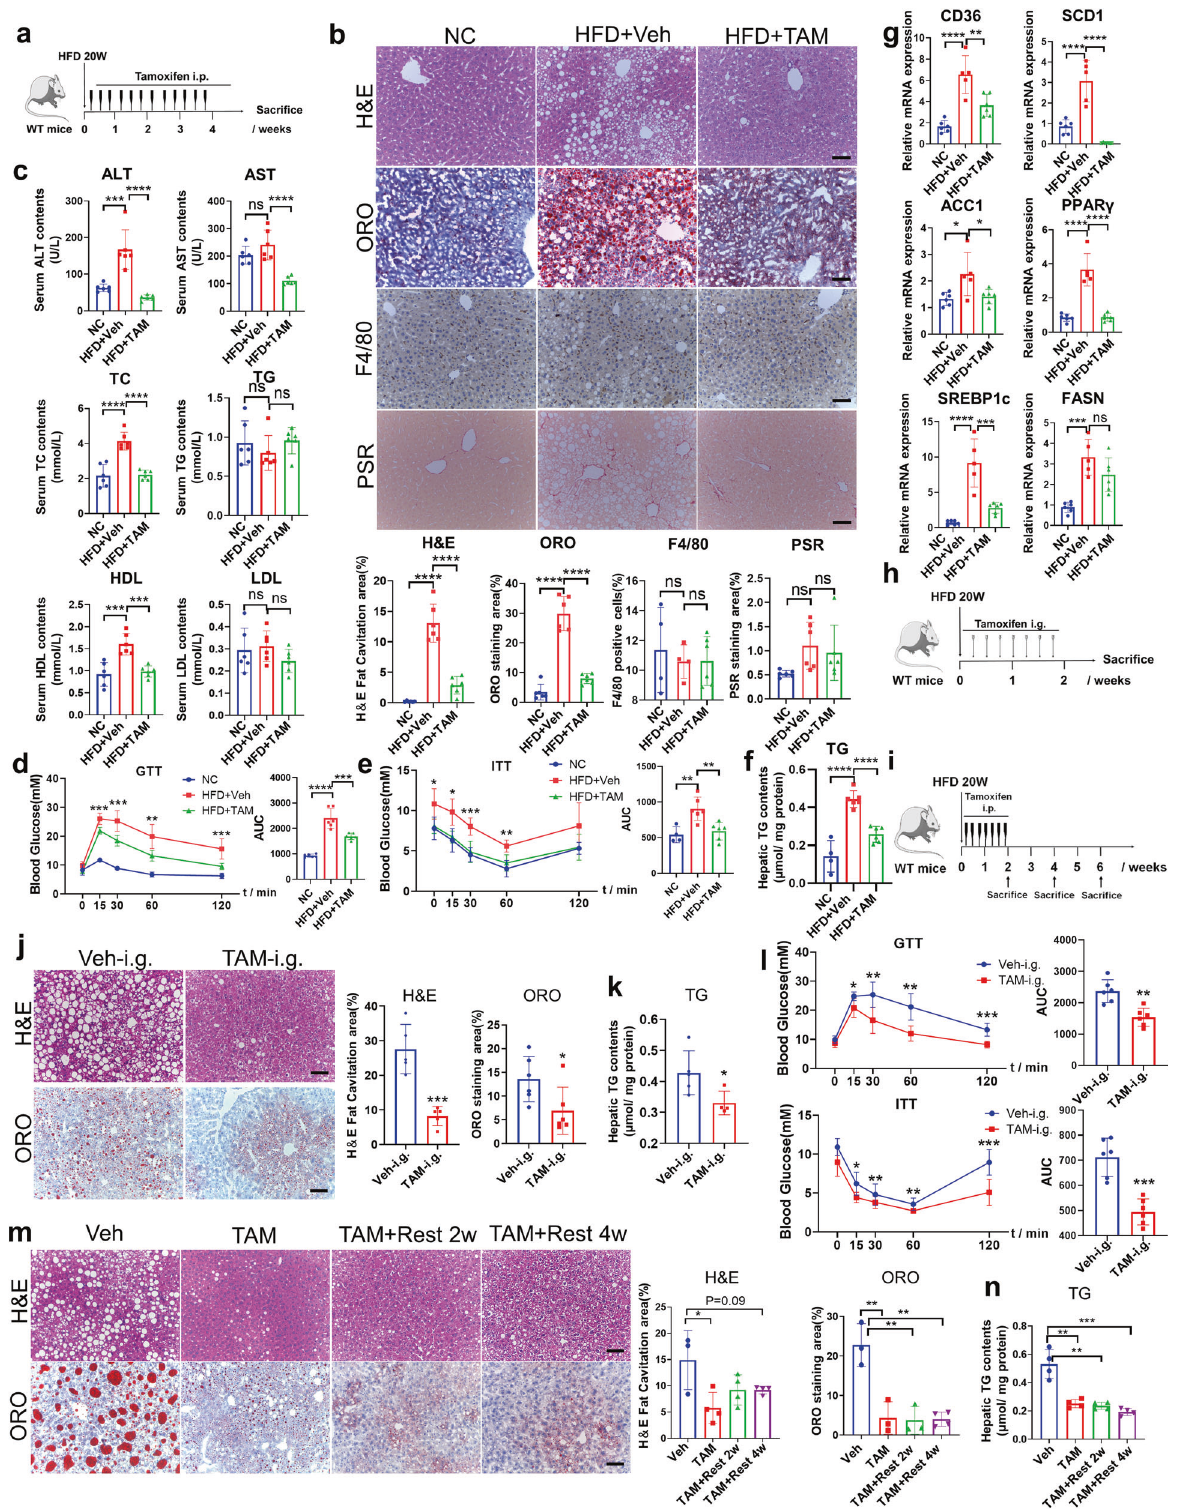
To exclude the potential interference of fulvestrant on extra- hepatic tissues, we use ER shRNA to suppress the expression of ER on AML12 cell line. RT-qPCR and WB results suggested that ER shRNA decreased cellular ER expression notably (Supplementary Fig. S10d, e). Consistently, the effect of tamoxifen on